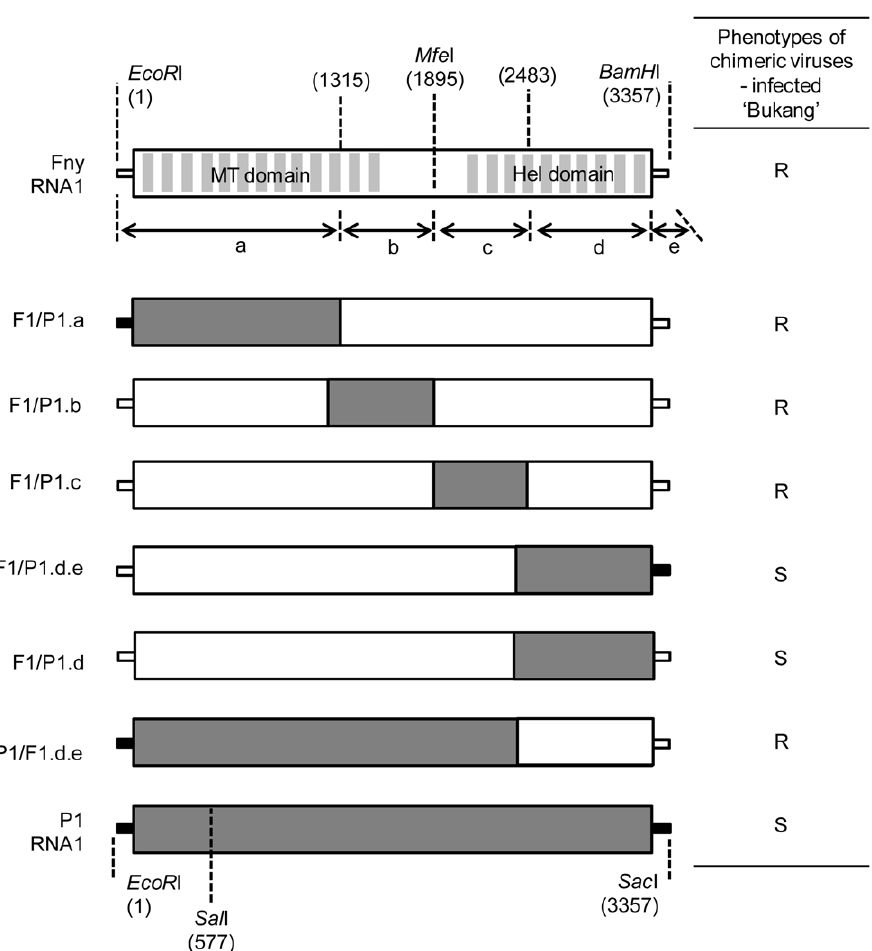
Figure 2. Schematic diagram of CMV RNA1 chimeric viruses. White boxes and gray boxes indicate Fny-derived regions and P1-derived regions, respectively. Dotted lines show the exchange position or the common restriction site between CMV-P1 and CMV-Fny used in the construction of the chimeras. R, resistant; S, susceptible.